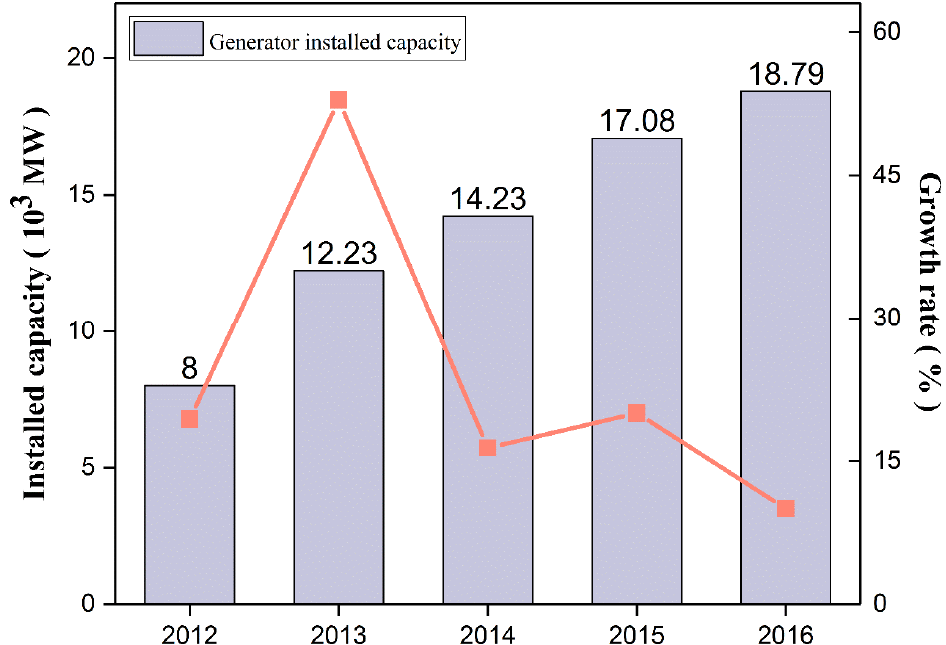
Figure 1. Installed capacity of biomass power generation in China from 2012 to 2016. Note: The original data were obtained from the database of National Renewable Energy Information management Centre in China.